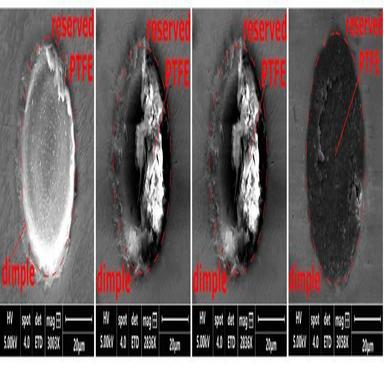
(a)- (d) SE images of Type A (wide & deep) dimples from run-in to steady stage (area 1-4 marked in Fig. 12), (e)-(h) BSE images of Type A (wide & deep) dimples from run-in to steady stage (area 1-4 marked in Fig. 12).